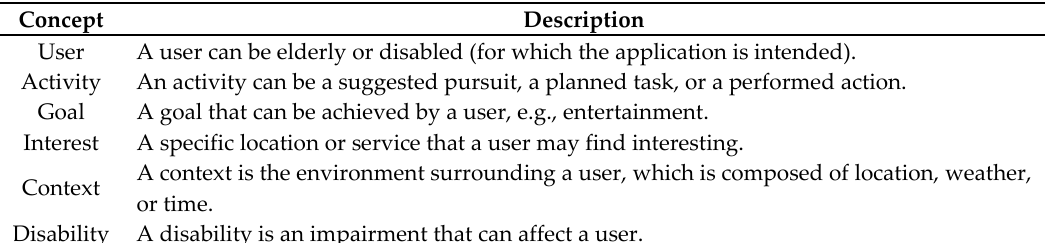
Figure 2. User Profile ontological model. Table 3. Description of user profile ontological